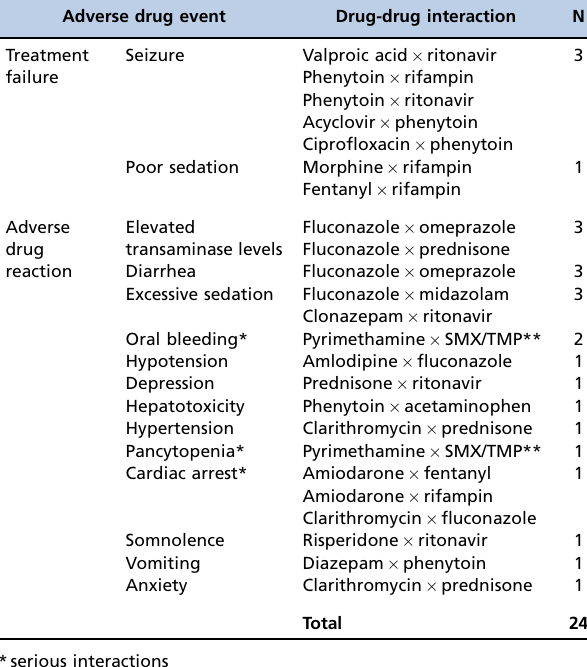
Table 1 - Adverse drug events related to drug-drug interactions in patients admitted to the ICU at INI (N=24). Adverse drug event